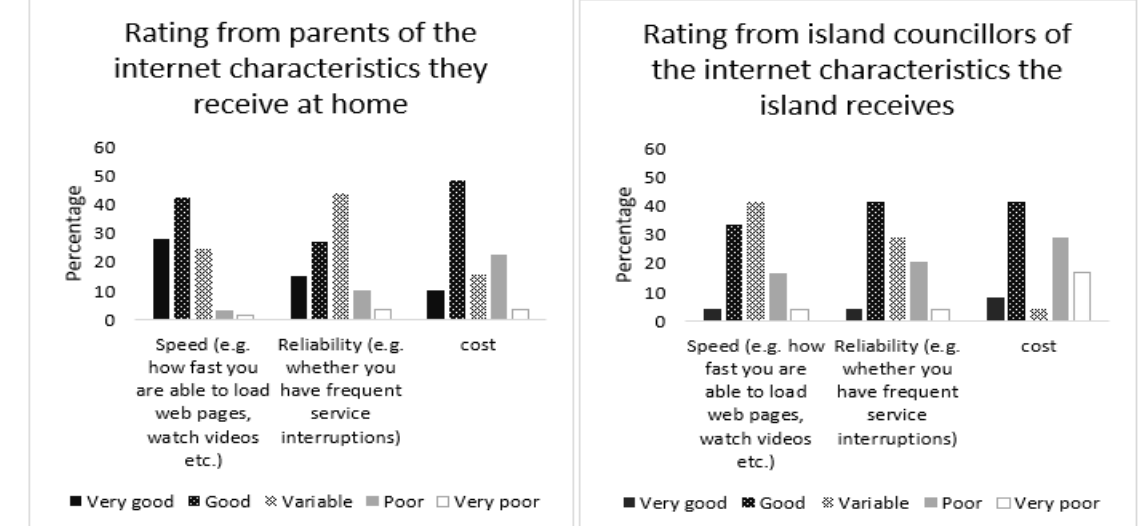
Figure 3(a). Rating of internet characteristics accessed at home as indicated by parents. Figure 3(b). Rating of internet characteristics accessed in islands as indicated by island